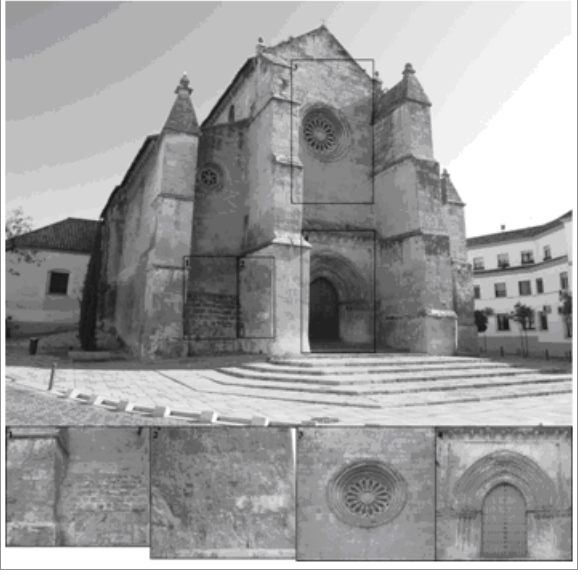
that were studied.